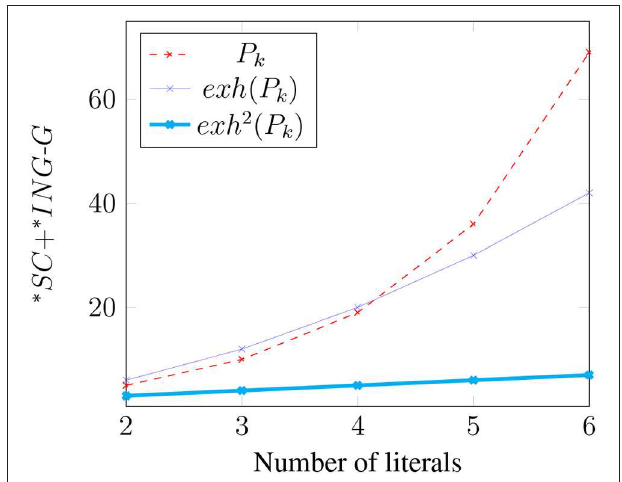
FIGURE 2 | Cost of update (to be